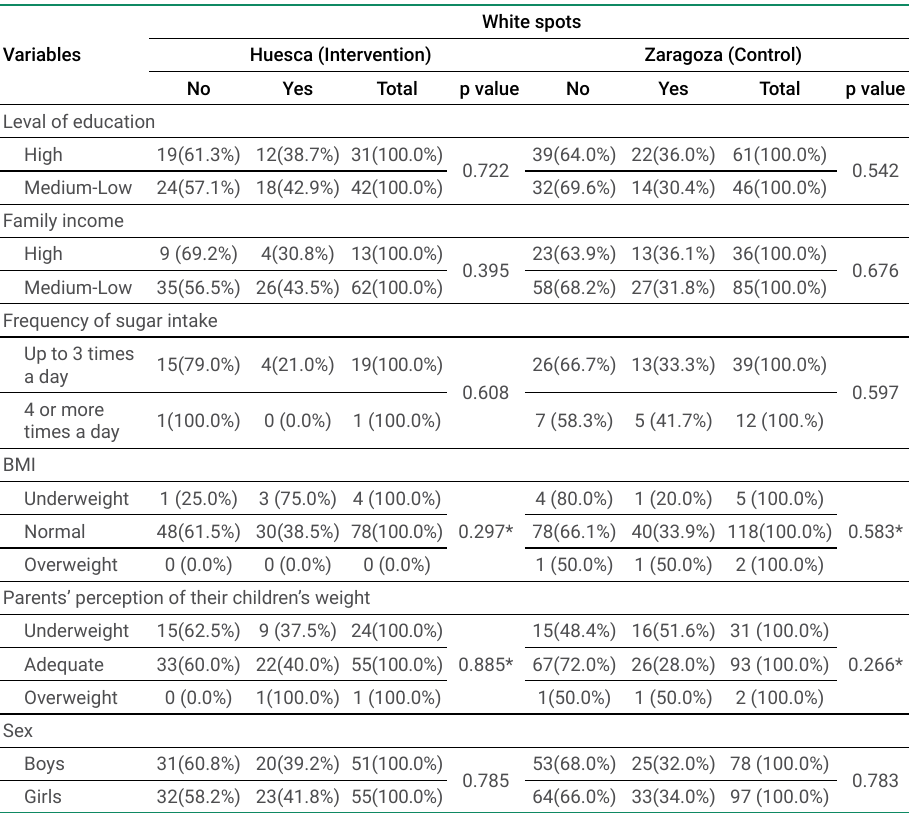
Table 4. Bivariate analysis for 7 to 11-year-olds per city in the IDEFICS study in Spain, for white